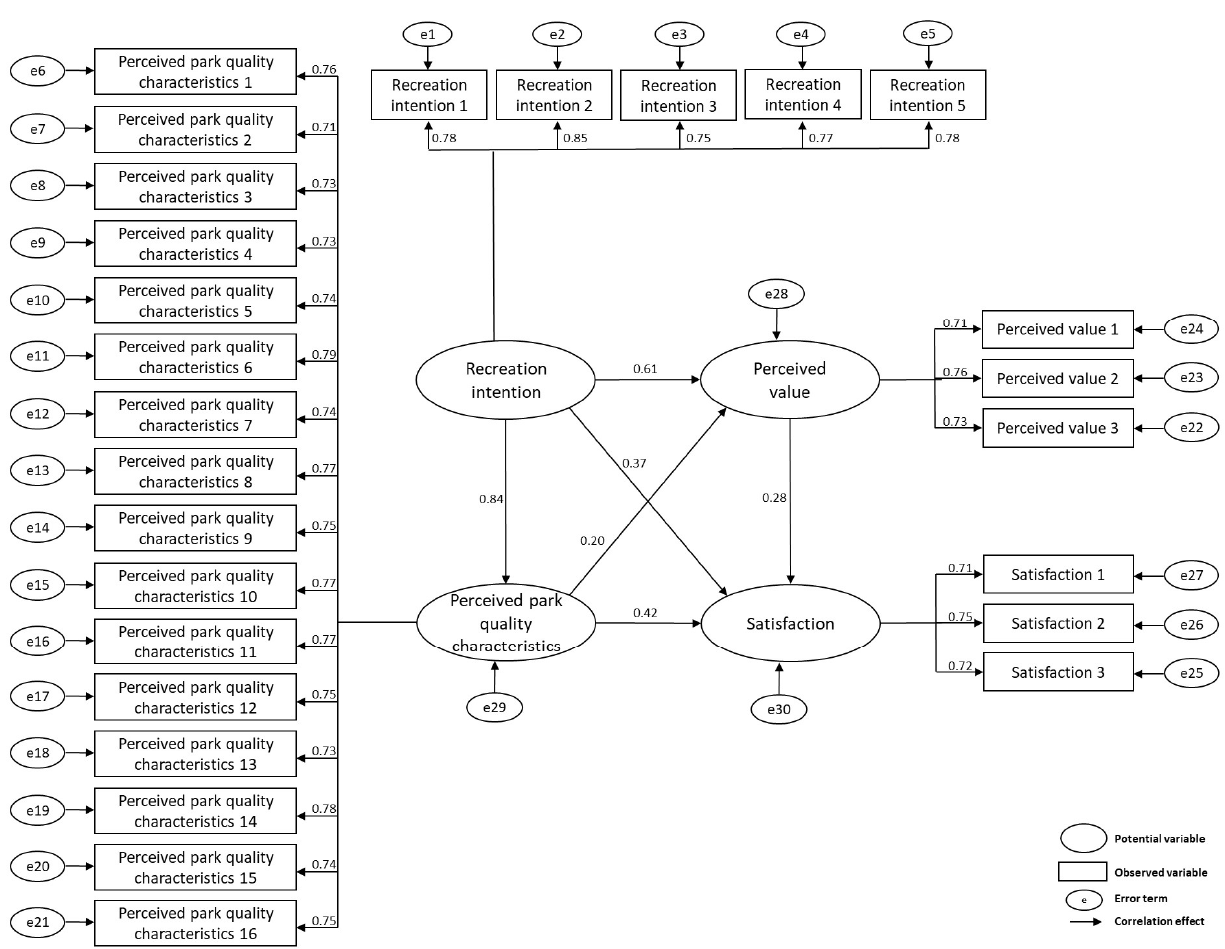
Figure 5. Structural equation model.